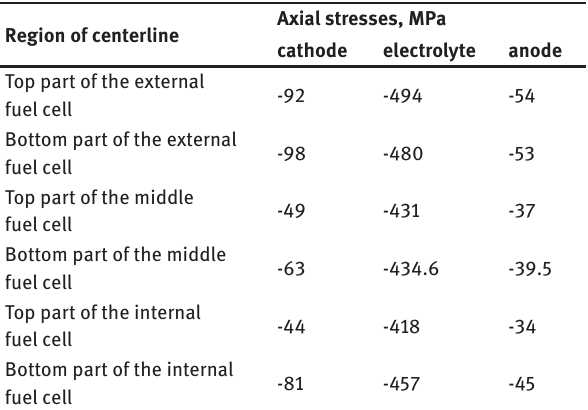
Table 3: Values of the total axial stress component in the assembly: mSOFC stack, sealants, manifolds for cross-section regions at half- length of fuel